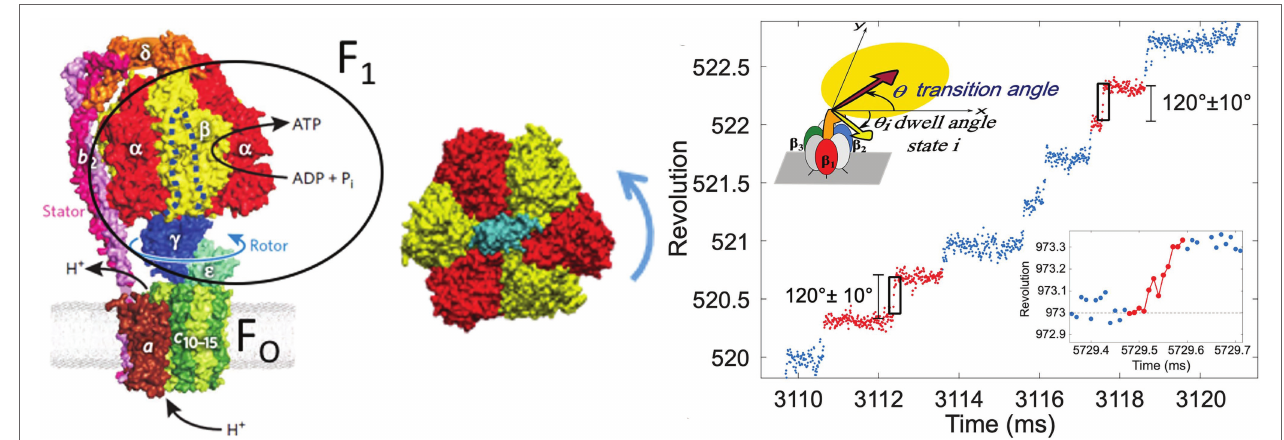
FIGURE 1 | F-ATPase structure showing the F1 and Fo components (left). F1-ATPase motor “transverse cross-section” view showing the central rotor in blue and α ring subunits in gold and β subunits in red (center). Example of a trajectory showing stepping rotation of F1-ATPase (right), as imaged by a probe in single molecule experiment (top inset). A transition is shown (red points) between two dwells (blue dots) in the lower inset. Figures were reproduced, with permission from Weber (2010) and Volkán-Kacsó et al.